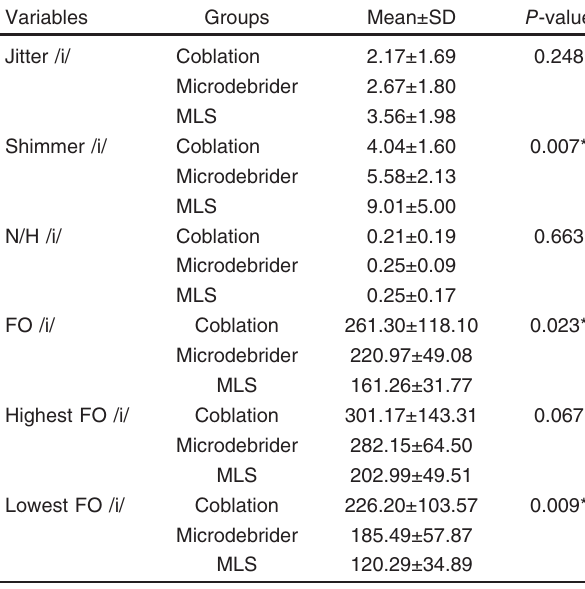
Table 4 Comparison between the three groups regarding baseline data of computerized speech lab. /i/